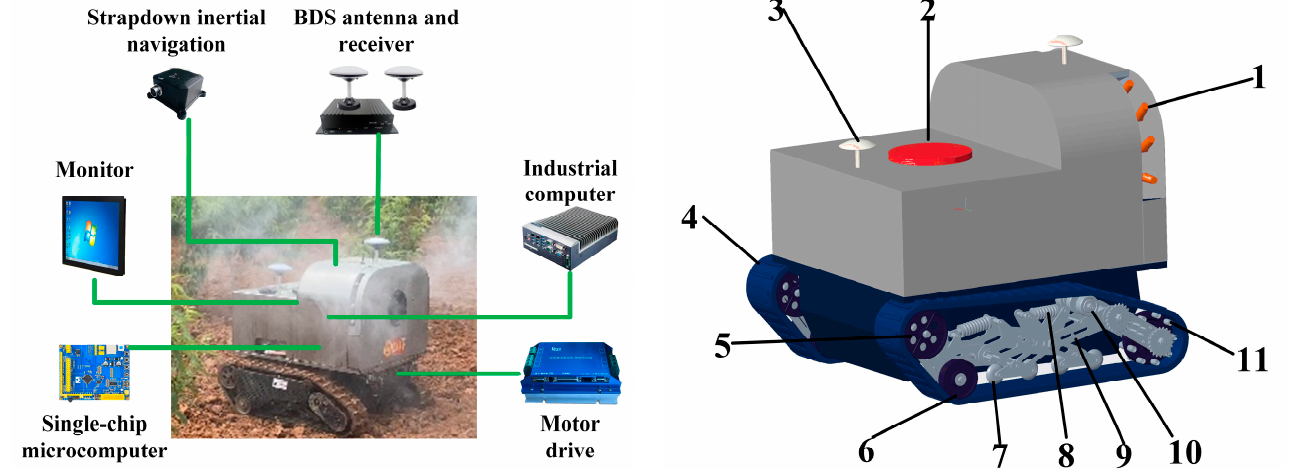
Figure 2. Physical construction of the orchard spraying robot. Note: 1 is sprinkler; 2 is medicine tank; 3 is BDS receiver antenna; 4 is track; 5 is upper guide wheel; 6 is lower guide wheel; 7 is trust wheel; 8 is suspension tension spring; 9 is suspension; 10 is supporting wheel. 11 is driving wheel.